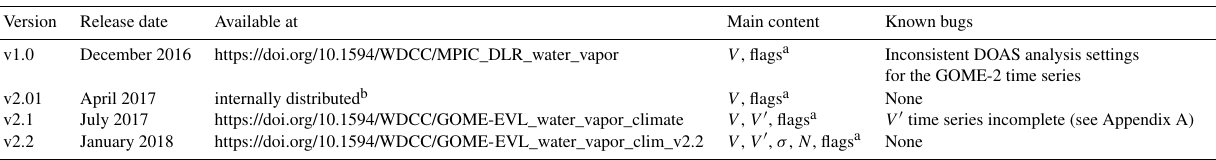
Table 3. Version history of the climate